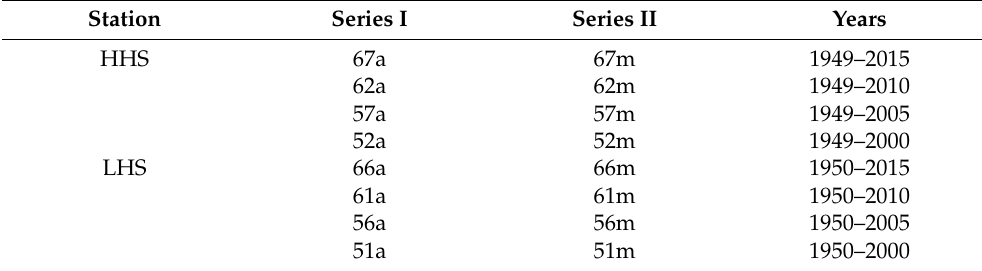
Figure 1. The location of Huayuankou and Lijin stations in the Yellow River basin. Table 1. Trend significance test of annual and monthly mean runoff series at HHS and LHS.